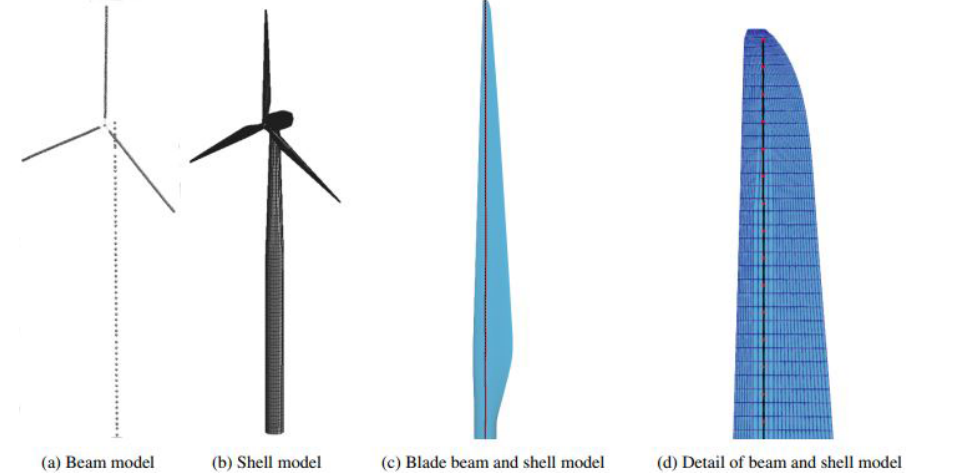
Figure 4. Beam and shell structural